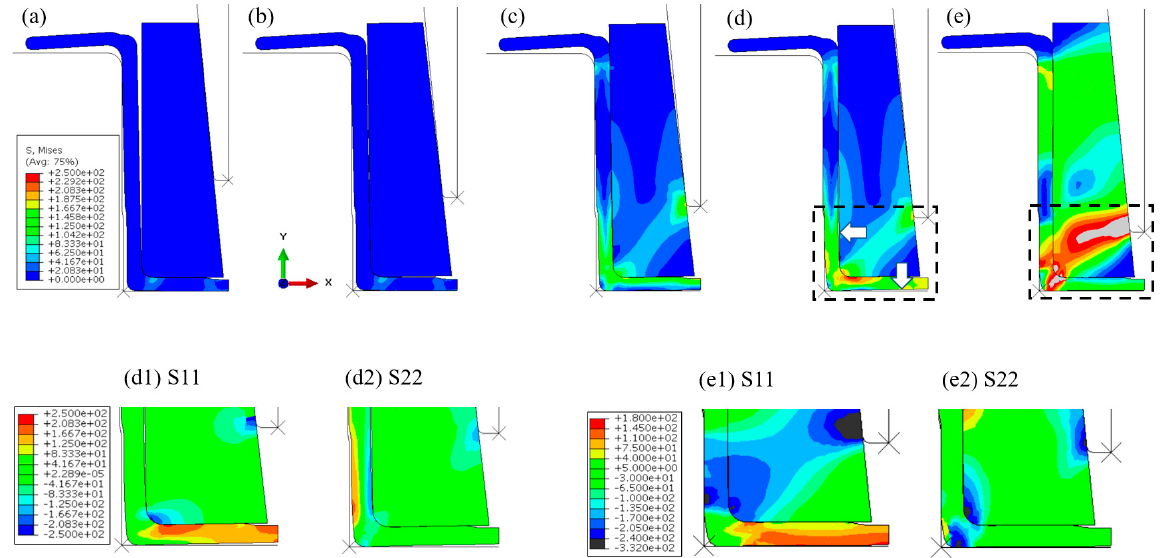
Figure 8. Von Mises stress evolution of the profile in the TSLB process: ( a ) initial state; ( b ) block rotating; ( c ) full contact stage of the block side to the profile side; ( d ) full contact on the bottom; and ( e ) final state and ( d1 , d2 , e1 , e2 ) stress components S11 and S22 during the last two stages.